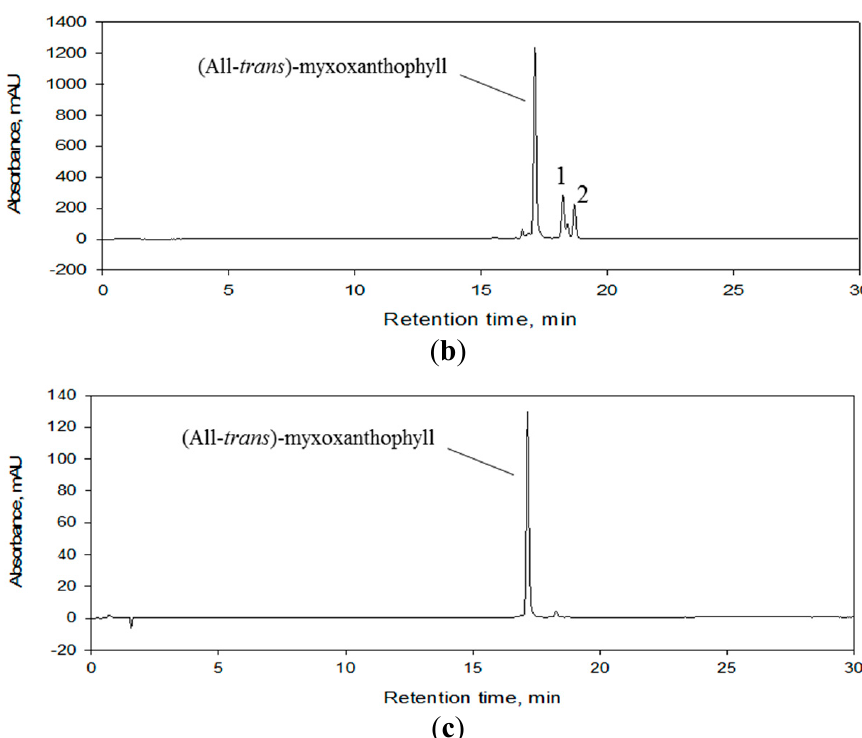
Figure 5. High performance liquid chromatography with diode array detection (HPLC-DAD) chromatograms of S. salina extract ( a ), myxoxanthophyll fraction obtained by HPCCC ( b ), and myxoxanthophyll further purified by HPLC ( c ). The chromatograms were monitored at 478 nm. 1: (13 or 13 ′ - cis )- myxoxanthophyll. 2: (9 or 9 ′ - cis )- myxoxanthophyll.